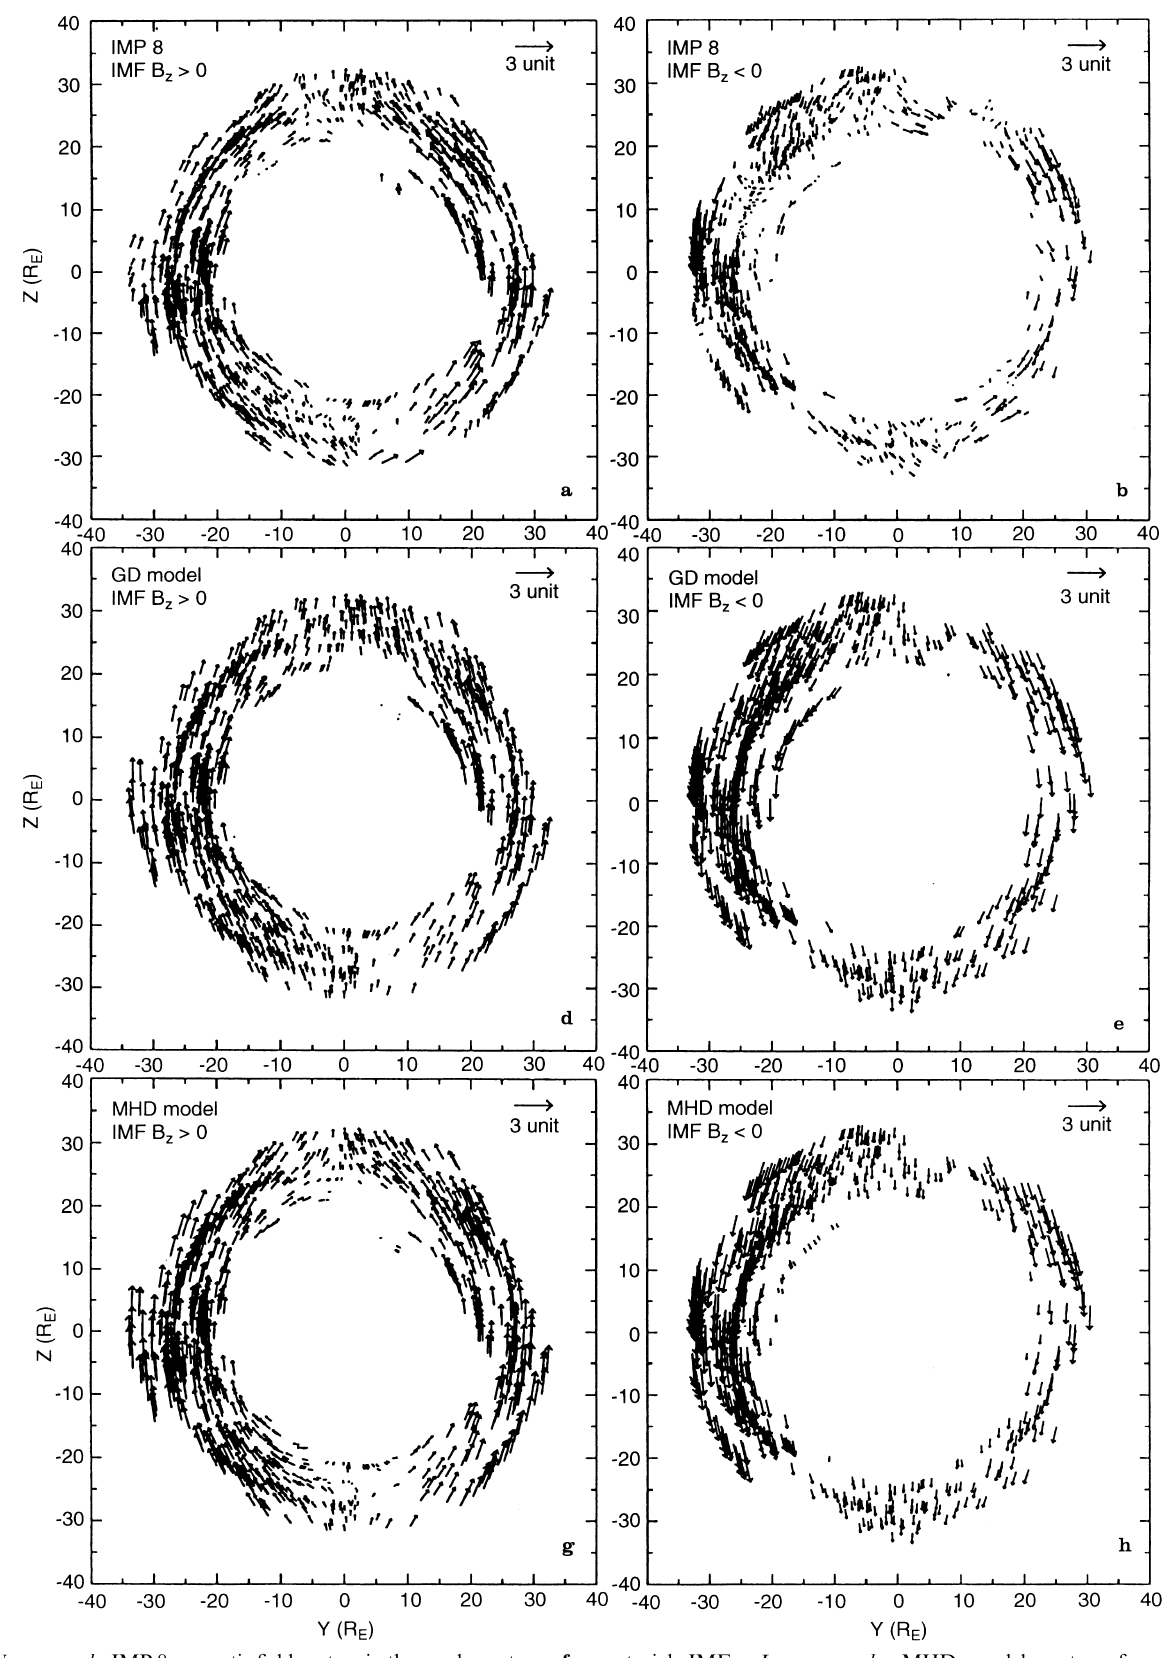
Fig. 1a-i. Upper panels : IMP 8 magnetic field vectors in the yz-plane at ) 30 Re for a northward, b southward, and c equatorial IMFs. Middle Panels : gas dynamic model vectors for d northward, e southward, and